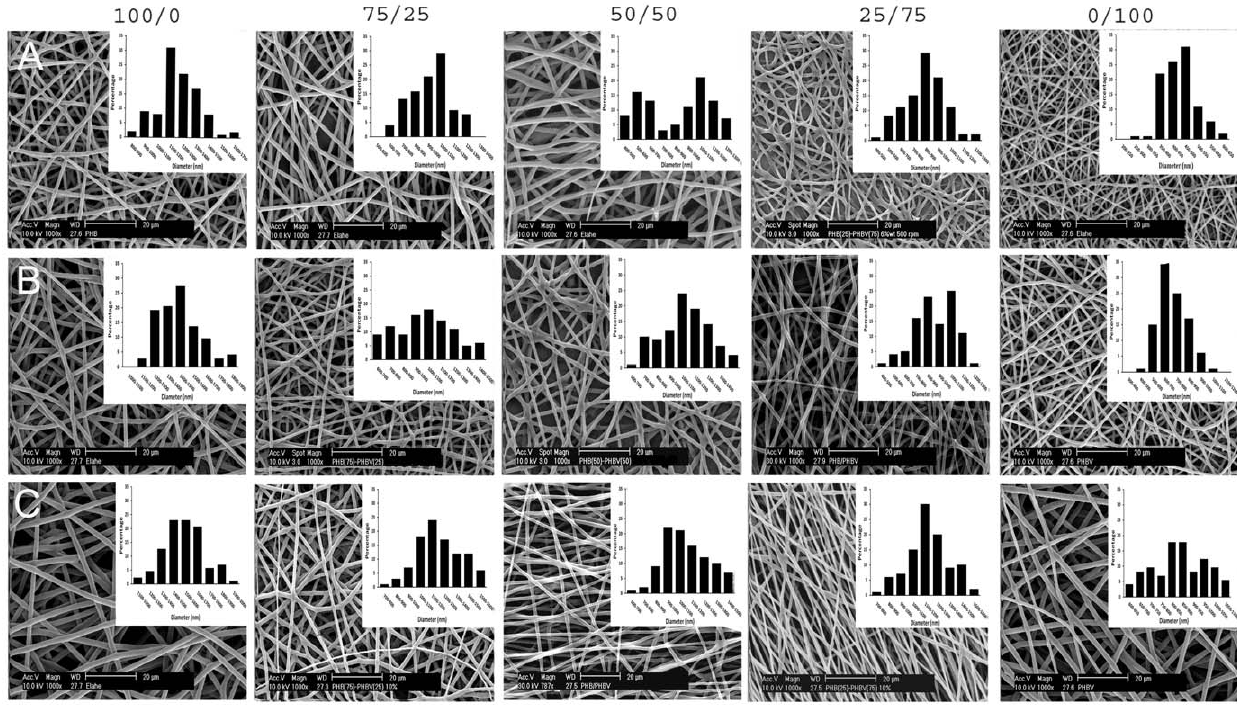
Figure 1. SEM images and histograms illustrating the diameter distribution of PHB/PHBV nanofibers. Polymer concentrations of (A) 6, (B) 8 and (C) 10% wt/wt were used. The voltage, flow rate and collecting conditions were fixed at 16 kV, 1.5 ml/h and 15 cm, respectively. Scale bars represent 2 0 m m for SEM images. Y axis range is 0–35% for all histograms. X axis ranges are 800–1700 nm (A 100/0), 500–1400 nm (A 75/25), 400– 1300 nm (A 50/50), 400–1300 nm (A 25/75), 200–650 nm (A 0/100), 1000–1900 nm (B 100/0), 600–1500 nm (B 75/25), 600–1500 nm (B 50/50), 400– 1300 nm (B 25/75), 300–1200 nm (B 0/100), 1100–2000 nm (C 100/0), 700–1600 nm (C 75/25), 600–1500 nm (C 50/50), 700–1600 nm (C 25/75) and 600–1100 nm (C 0/100).